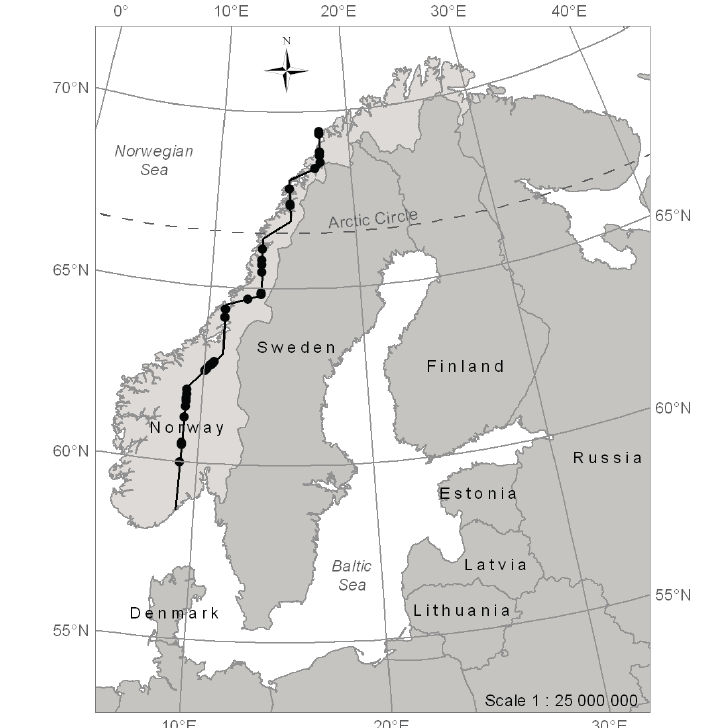
Figure 1. Overview of the study area with the 35 specified field sites (black dots). The 1500 km long transect (black line) stretches from 69°32 ′ 25 ″ N, 17°46 ′ 0 ″ E to 58°36 ′ 6 ″ N, 9°1 ′ 50 ″